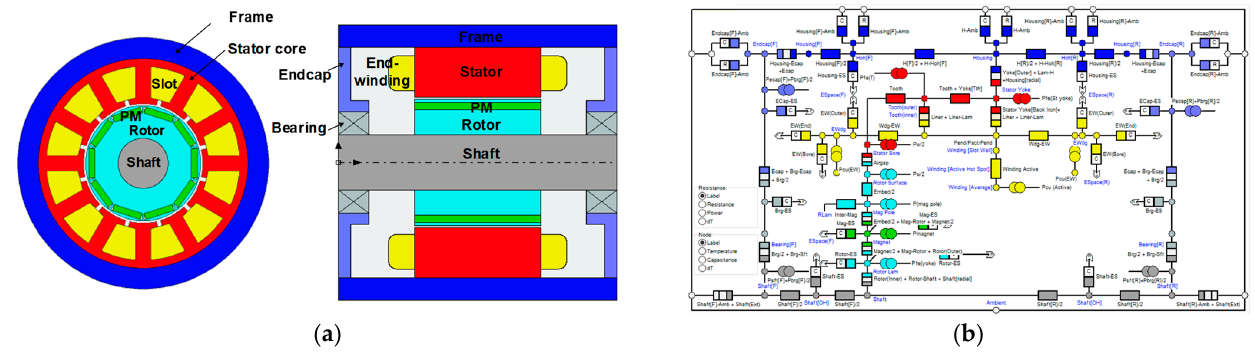
Figure 19. Sophisticated LPTM for a 12-slot/10-pole IPMSM [54]. ( a ) Machine topology. ( b ) Sophis- ticated LPTM in Motor-CAD.